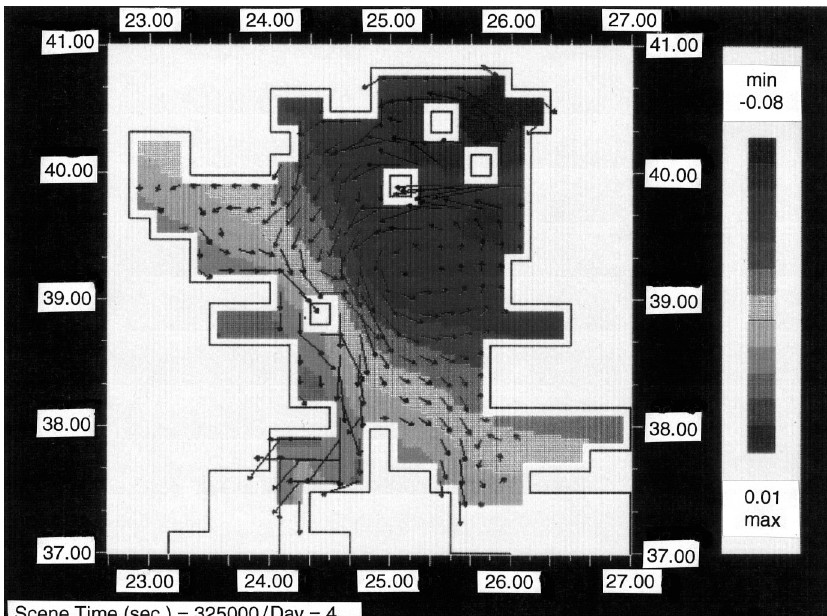
Fig. 4. A study case of barotropic flow in the North Aegean, with strong northerly winds and discharge from the Hellespont, where the flow model used is capable of simulating the main features of the local